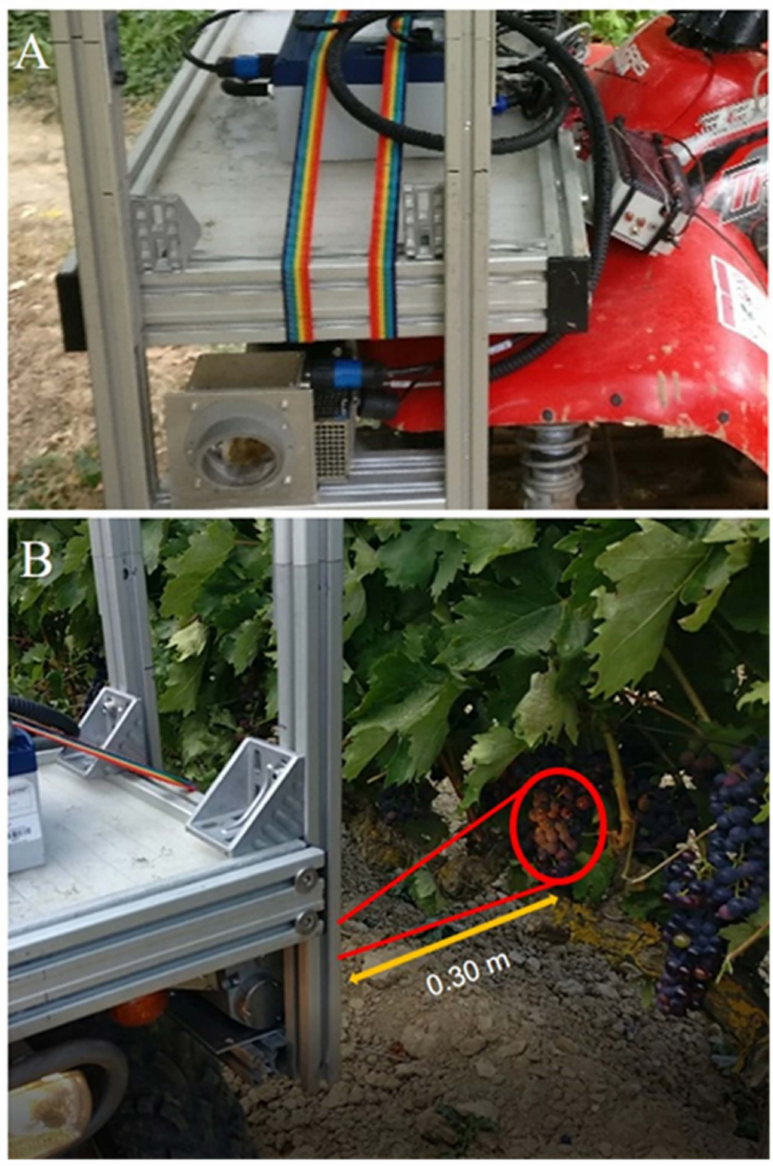
Figure 4. ( A ) Visible-Short Wave Near Infrared (VIS + SW − NIR) spectral acquisition system installed on the all-terrain vehicle (ATV) used for contactless on-the-go grape clusters spectral measurements in the vineyard. ( B ) Head sensor monitoring the grape cluster in